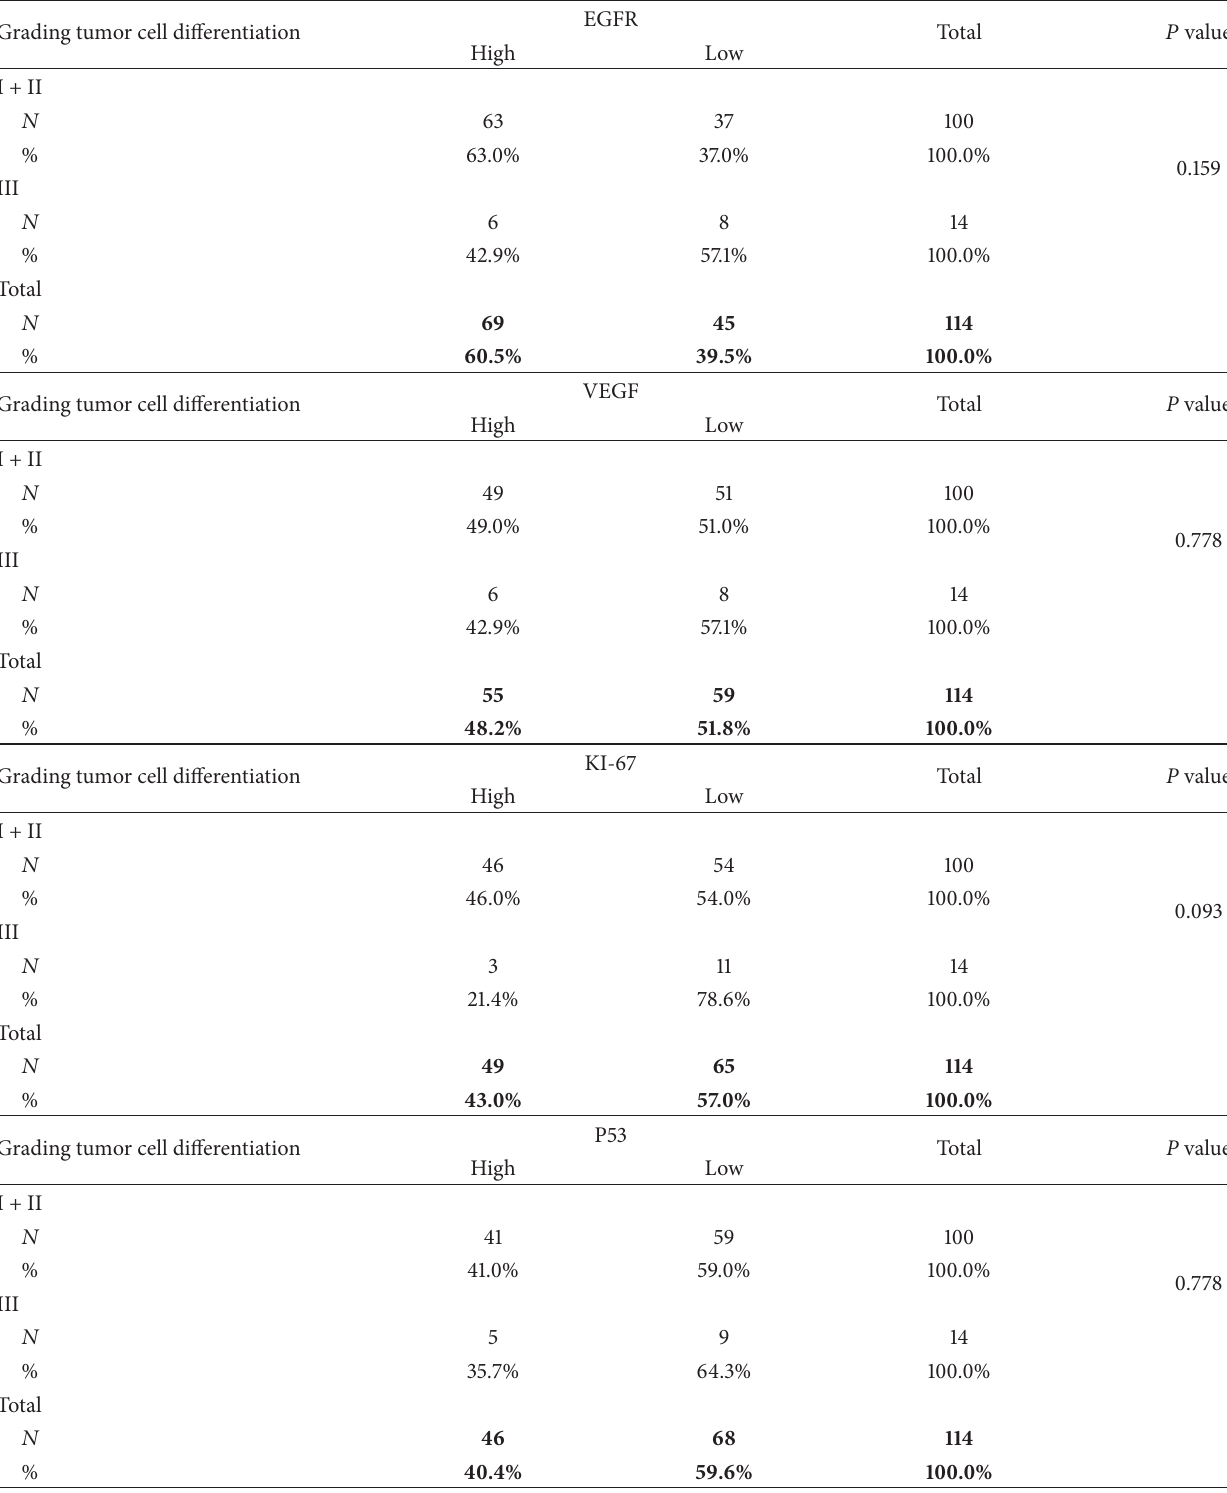
Table 3: Distribution of the expression levels PER IHC of proteins corresponding to ITGB-5, ITGA-3, MMP-2, MMP-9, and FN-1 ECM genes and EGFR, VEGF, KI-67, P53, and Bcl-2 molecules as per the degree of cell differentiation of CRC ( 𝑛 = 114 ). Grading tumor cell